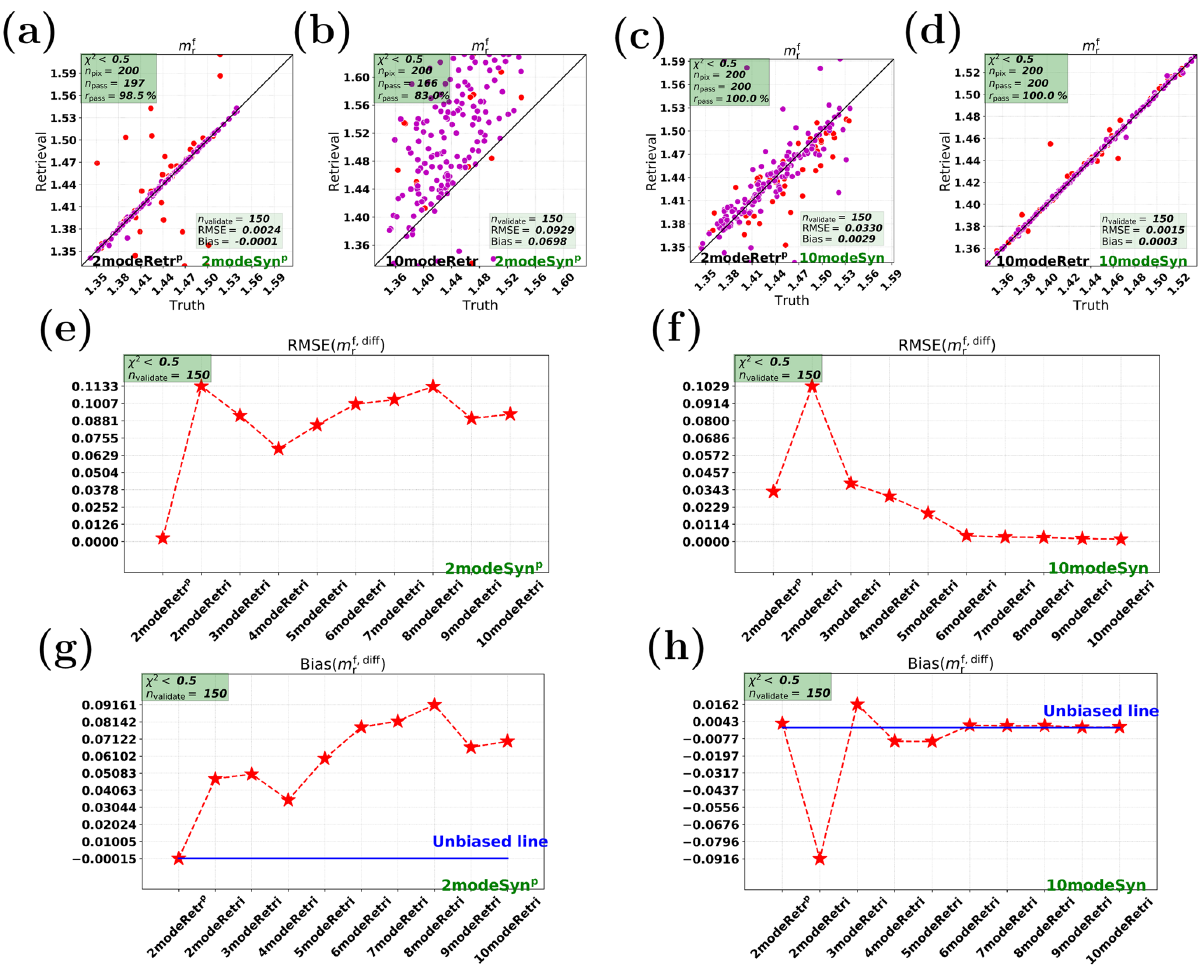
Figure 7. Synthetic retrievals for the real part of refractive index (at 550nm) of the fine modes ( m f r ). Panels (a, b, e, g) and (c, d, f, h) show cases on 2modeSyn p and 10modeSyn,